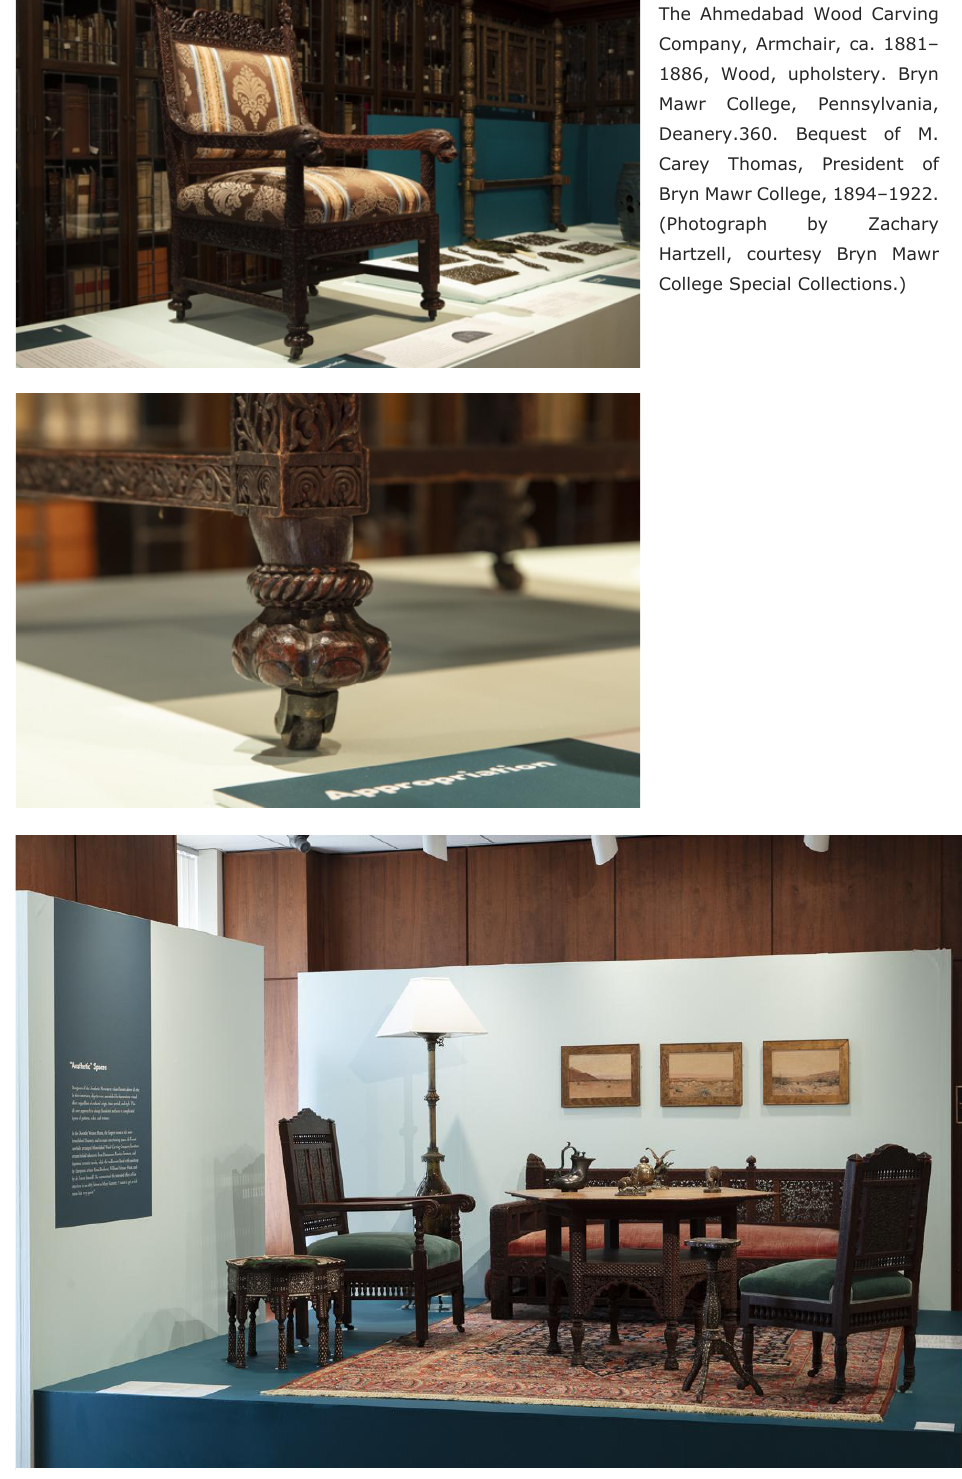
Installation shot, “All-Over Design”: Lockwood de Forest between Ahmedabad and Bryn Mawr. (Photograph by Zachary Hartzell, courtesy Bryn Mawr College Special